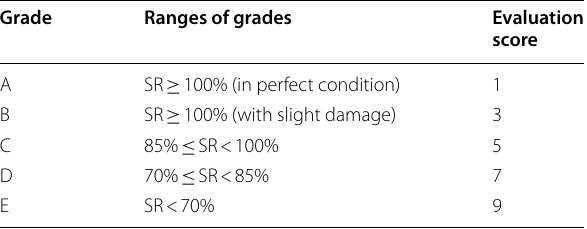
Table 2 Evaluation grades based on ratio of measured to designed member strength (KISTEC 2009)